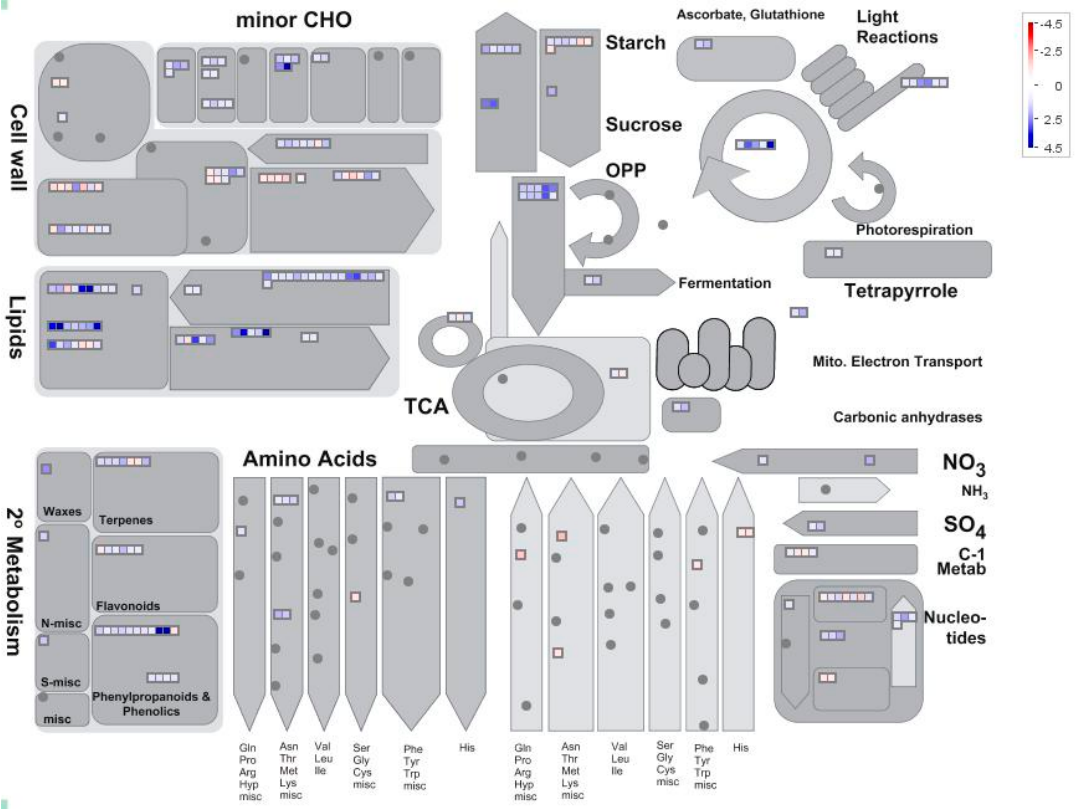
Figure 3. MapMan analysis of differentially expressed genes in soybean nodules. In the color scale, blue and red represent up-regulated and down-regulated expression, respectively, in response to Pi starvation within soybean nodules. Black dots represent no gene enrichment to the category entries. Numbers represent fold changes in expression levels expressed as Log 2 (LP/HP).